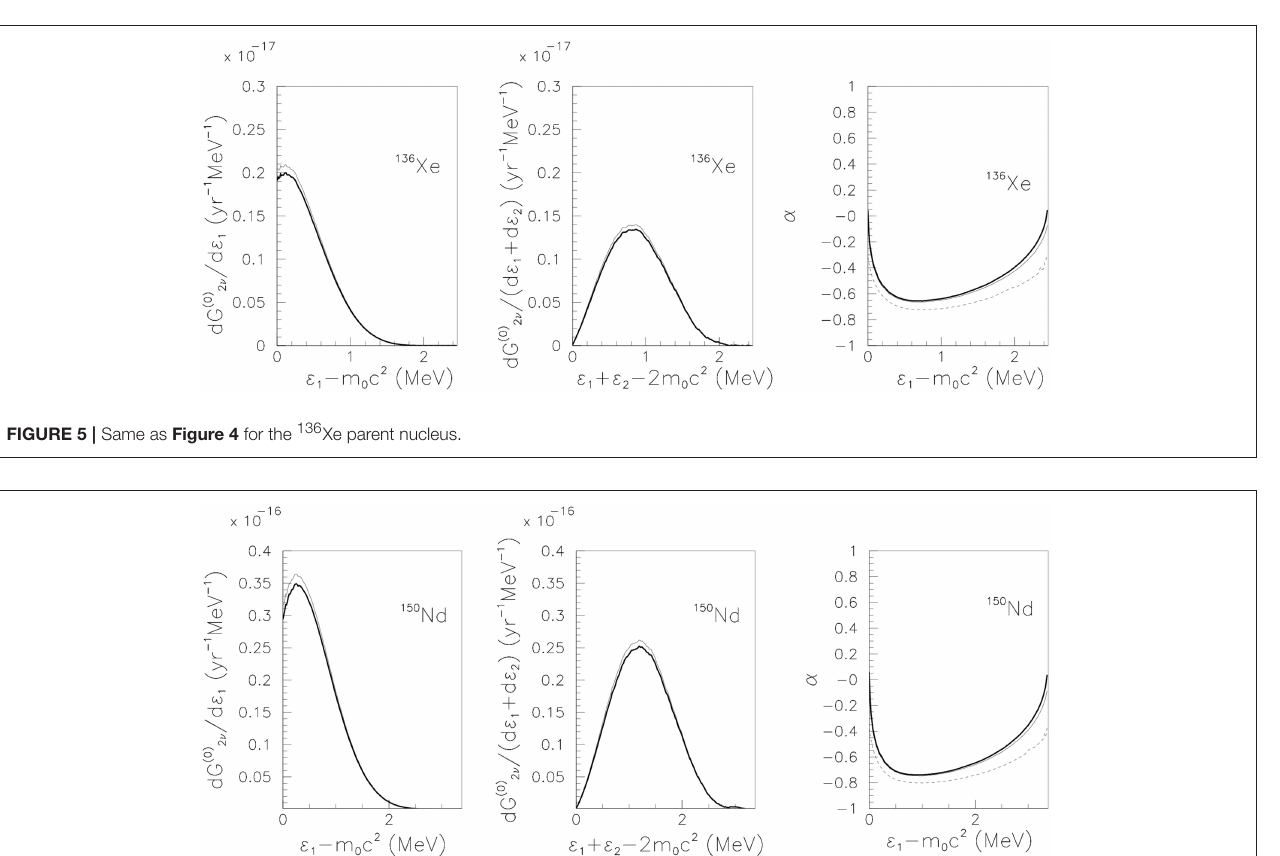
ǫ 2 ) and the angular correlation parameter α as function of the electron energies ǫ 1 and ǫ 2 FIGURE 4 | The normalized energy distributions dG (0) 2 ν / d ǫ 1 , dG (0) 2 ν / d ( ǫ 1 + for 82 Se parent nucleus β − β − decay are plotted with a full thick line. The results obtained by neglecting the screening effect are plotted with a full thin line. A thin dashed line is used for calculations in which the global phase shift of the Dirac wave functions is set to zero.